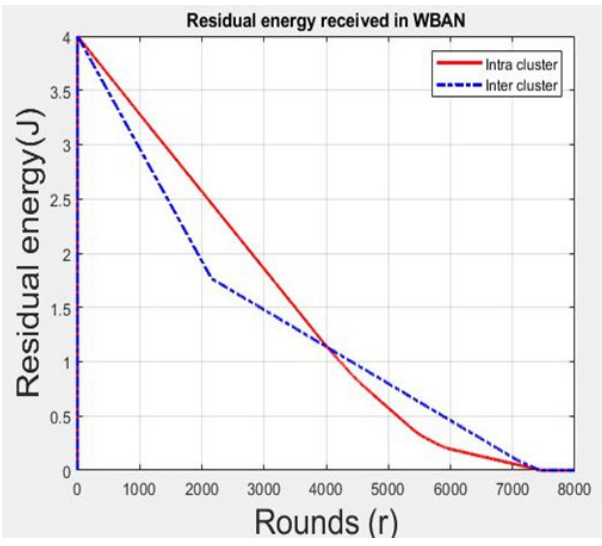
Figure 11. Residual Energy received in